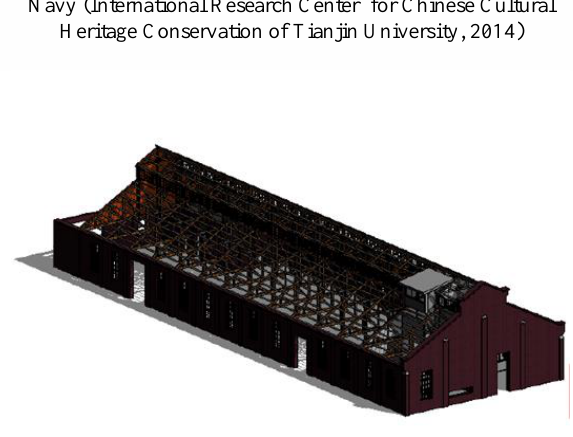
Figure 6 ． Post-earthquake machinery engineering